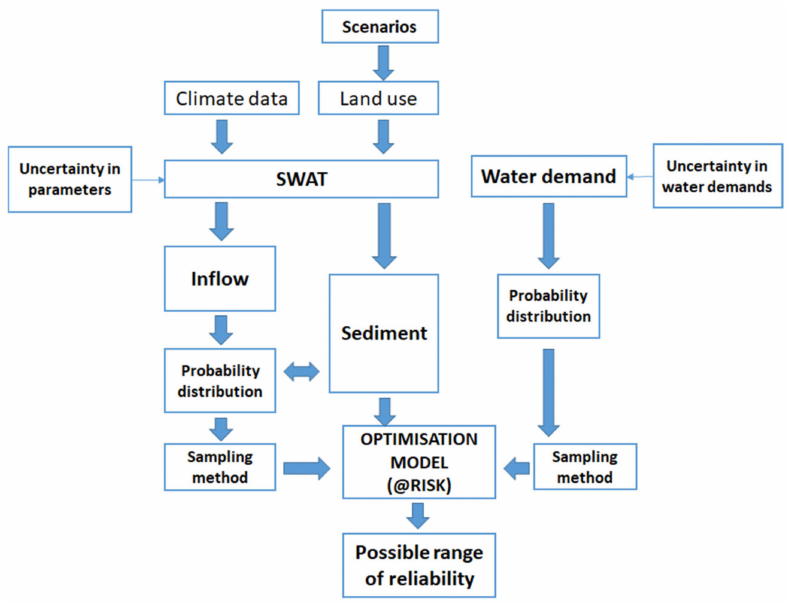
Figure 1. A framework to assess the impact of land-use change on reservoir water supply